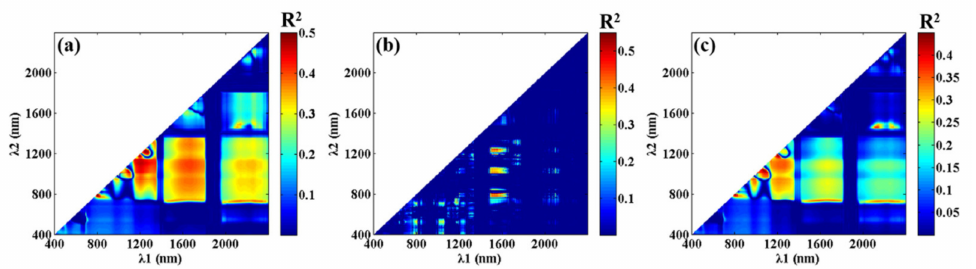
Figure 6. Contour maps of coefficients of determination (R 2 ) for linear relationships between rice plant potassium content (PKC) and normalized spectral indices (NDSI) based on reflectance spectra (R) ( a ), first derivative spectra (FD) ( b ), and reciprocal logarithm-transformed spectra (log (1/R)) ( c ), respectively. Lambda ( λ ) represents a wavelength from 400 to 2400 nm. (For interpretation of the references to colour in this figure legend, the reader is referred to the web version of this article).